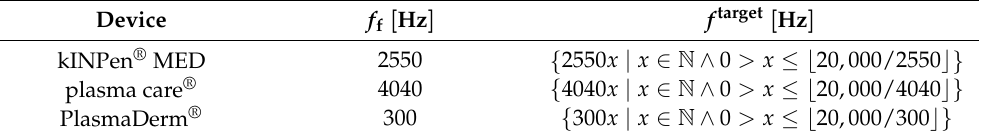
Table 1. Fundamental and target frequencies of the devices between 0 and 20,000 Hz (audible frequency